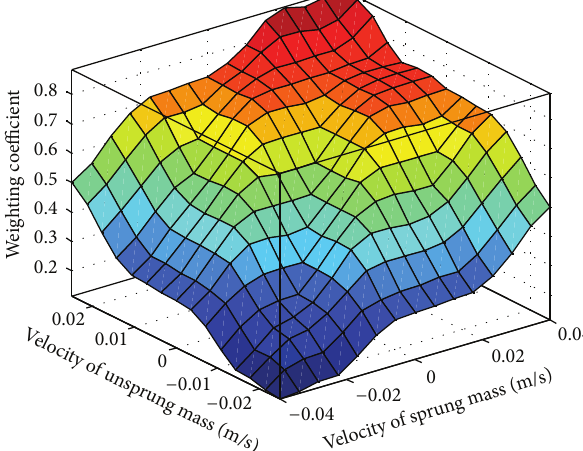
Table 2: Rules of the fuzzy controller.